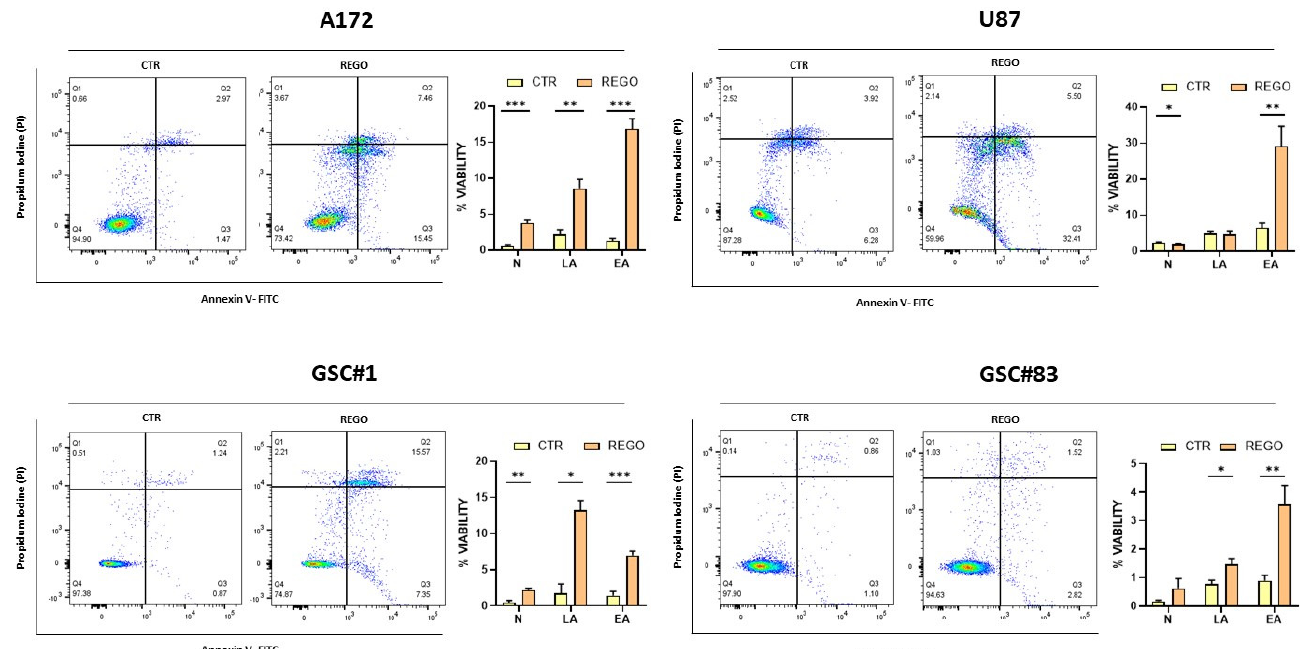
Figure 3. Annexin staining of cells treated with regorafenib for 48 h. Cells were double stained by annexin V and by propidium iodide, for apoptotic and dead-cell labeling, respectively. N: necrotic cells; LA: late apoptosis; EA: early apoptosis. n = 3 biological replicates. * p value < 0.05; ** p value < 0.01; *** p value < 0.001.